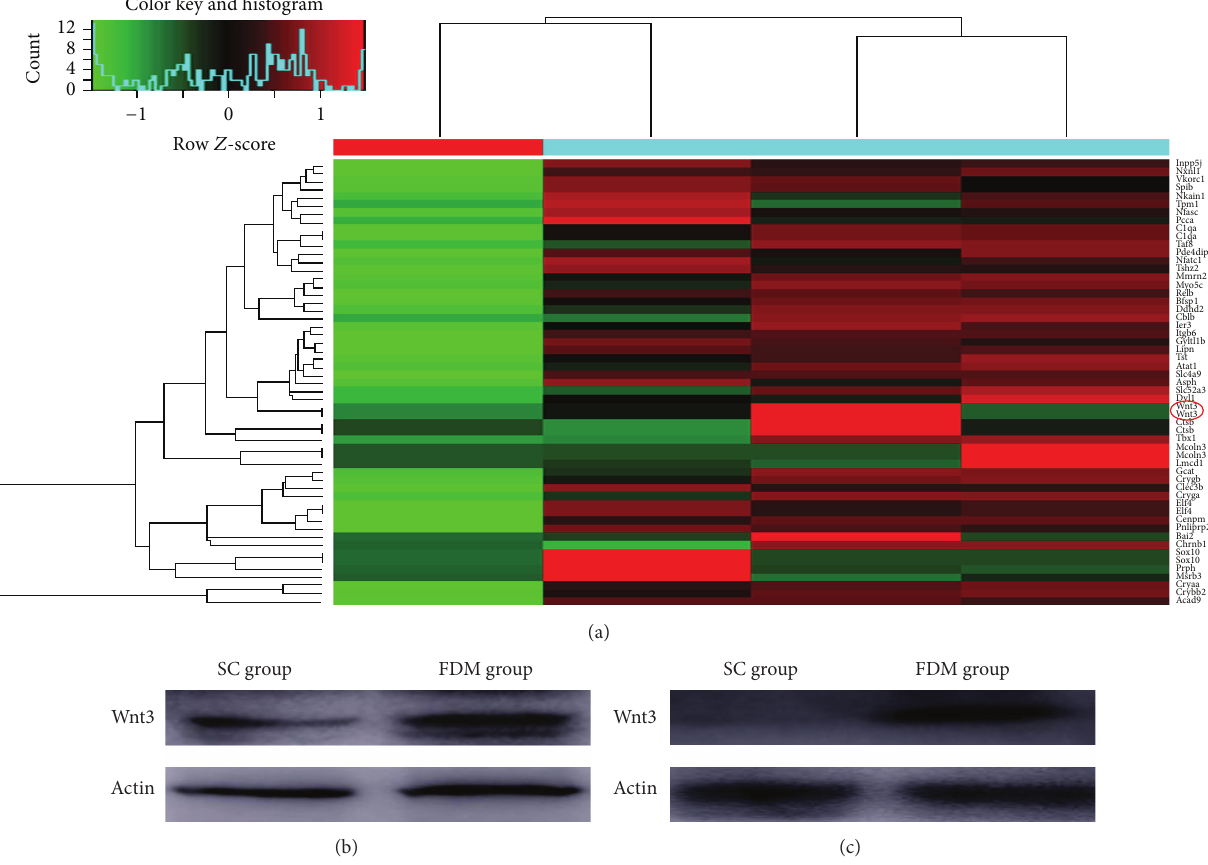
Figure2: ExpressionofWnt isoformsin form-deprivationmyopia guinea pig model. (a)Theresultof whole genomemicroarrays. (b)Western blot for the expression of Wnt isoforms in retinal tissue. (c) Western blot for the expression of Wnt isoforms in scleral